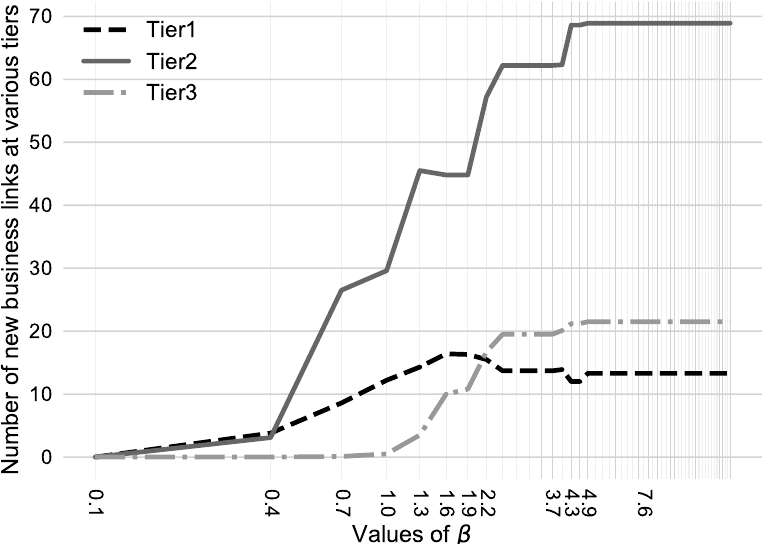
Figure 3. Number of new business connections, by tiers, for various β